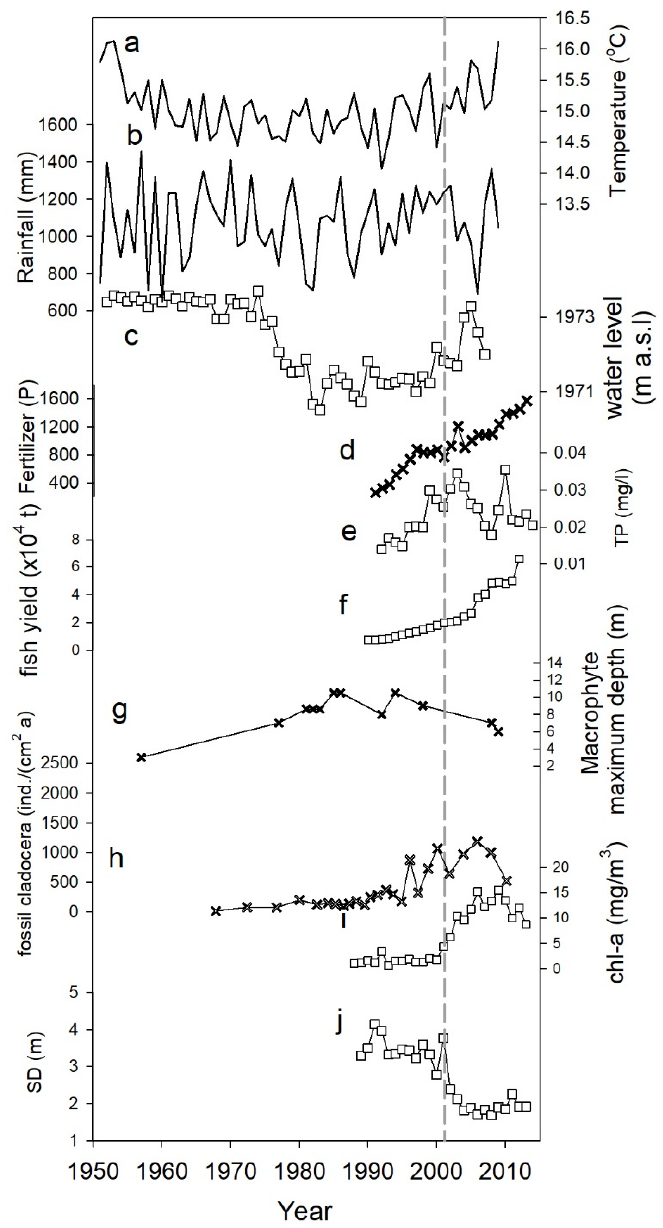
Figure 3. Monitoring data in Erhai. ( a ) Temperature variability between 1950 and 2010; ( b ) rainfall variability between 1950 and 2010; ( c ) water level between 1950 and 2010 (meters above sea level); ( d ) consumed phosphorus fertilizer (×10 4 t) in Dali city administration area; ( e ) total phosphorus (TP) in water; ( f ) fish yield from the lake; ( g ) maximum depth covered by macrophytes; ( h ) fossil Cladocera from the lake sediments; ( i ) concentration of chlorophyll-a (chl-a) in the water; ( j ) water clarity (SD).